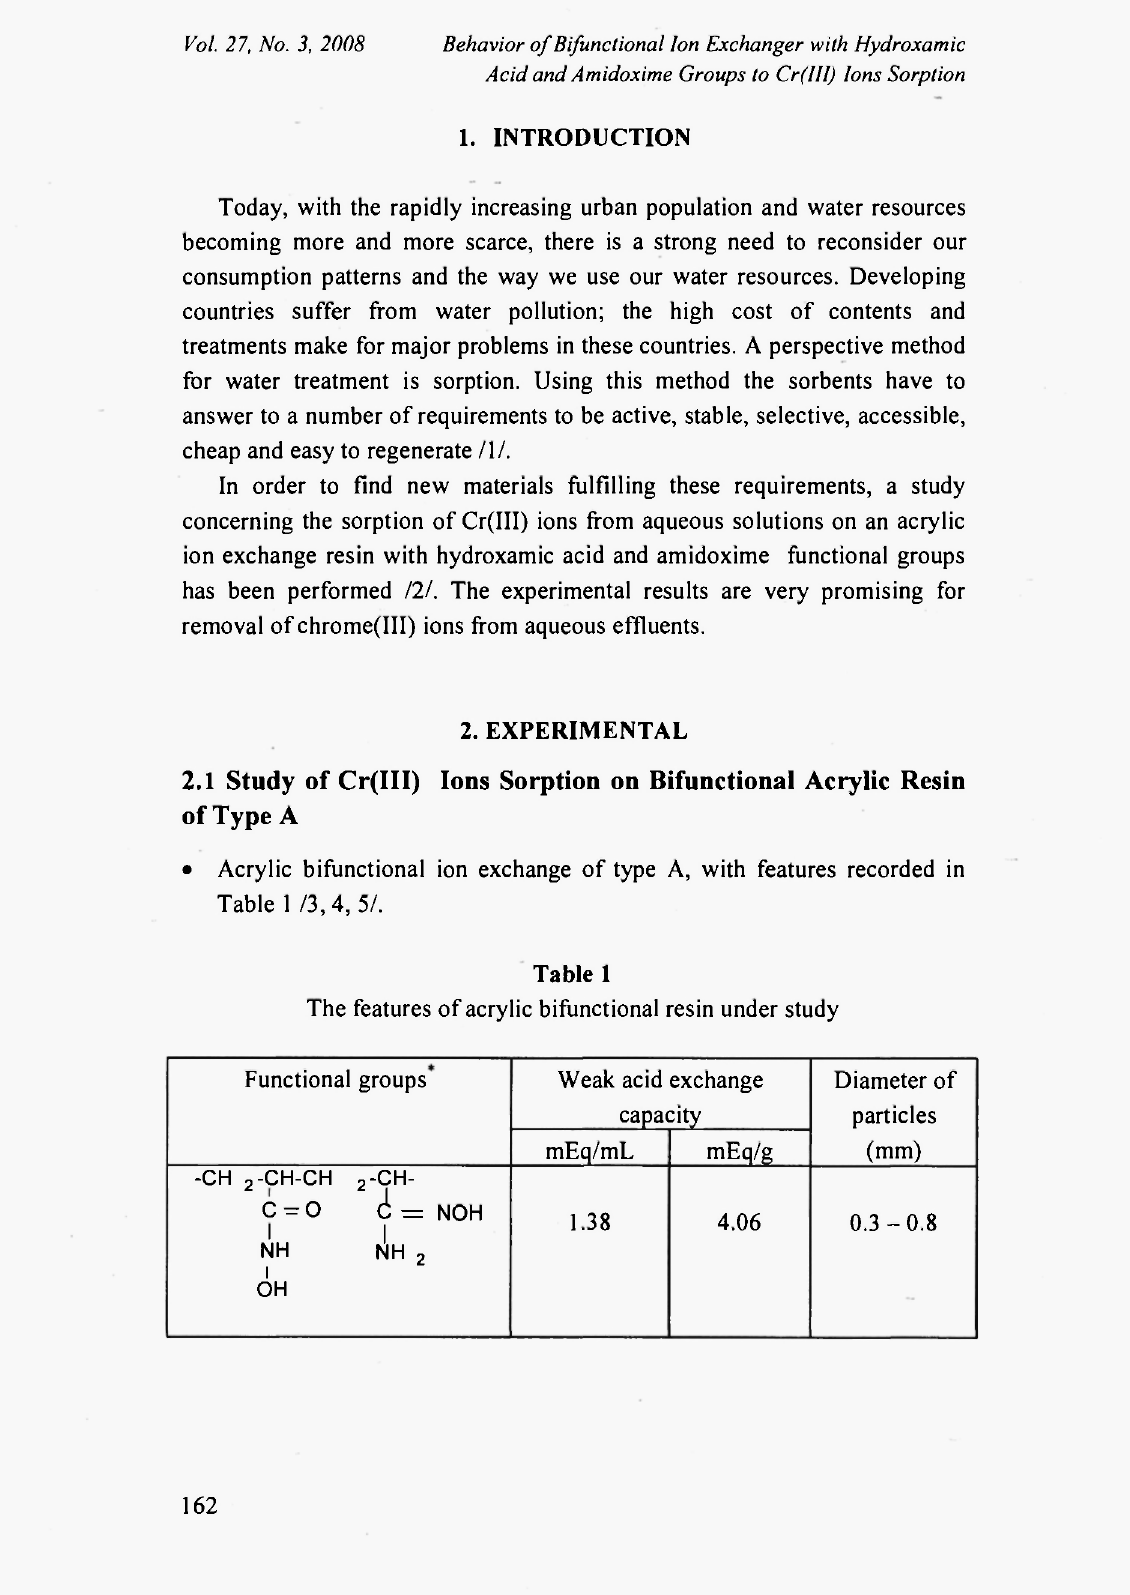
The features of acrylic bifunctional resin under study Functional